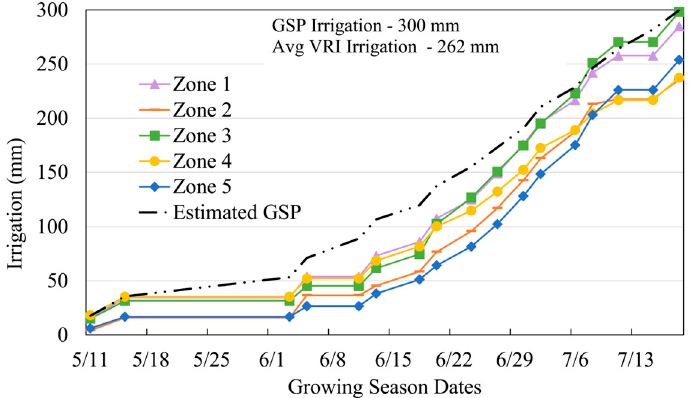
Figure 4. Cumulative irrigation for winter wheat in 2019 under variable rate irrigation (VRI) with five irrigation zones compared to the estimated cumulative grower standard practice (GSP) from 11 May to 18 July with irrigation events represented by the unique shapes for each zone.